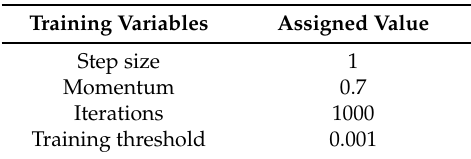
Table 1. Configurations of FRNN during